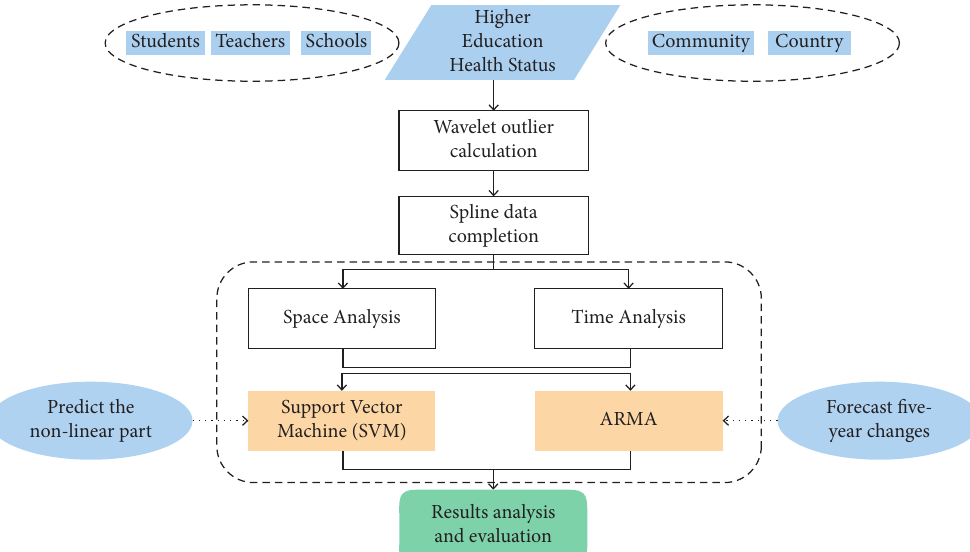
Figure 5: The ARMA-SVM-combined forecasting model.